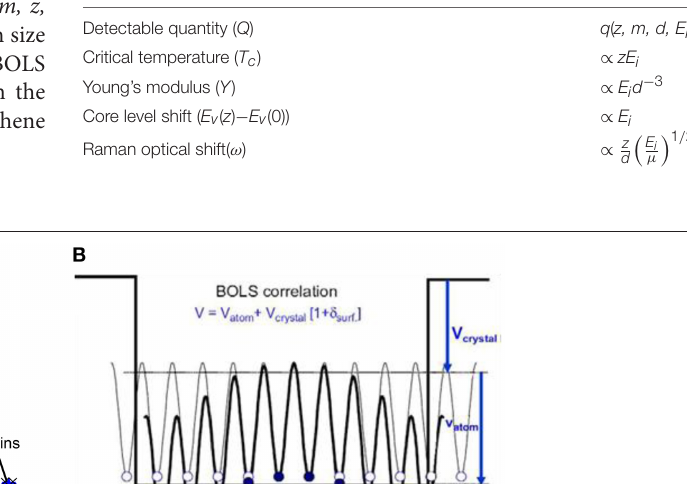
TABLE 2 | Formulation of the measurable quantities on the bonding parameters [14].